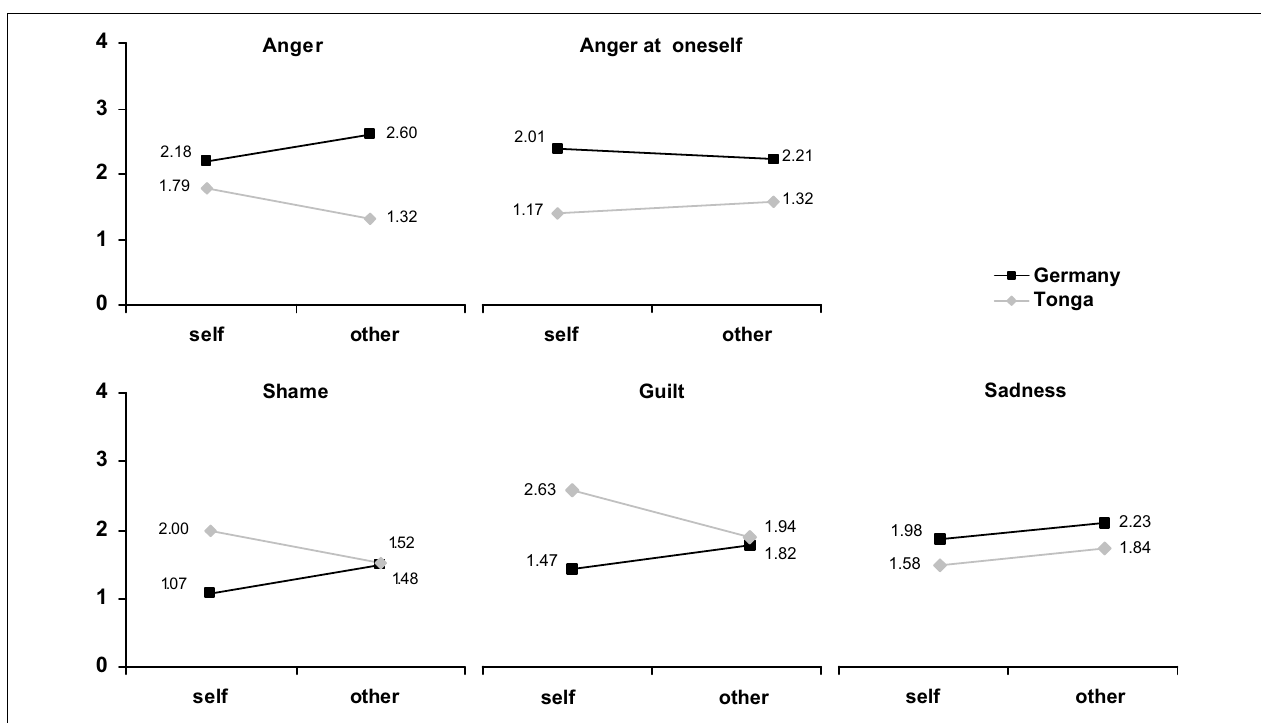
FIGURE 2 | Reported frequency ratings for anger, anger at oneself, shame, guilt, and sadness as a function of culture and reference (self vs. other).